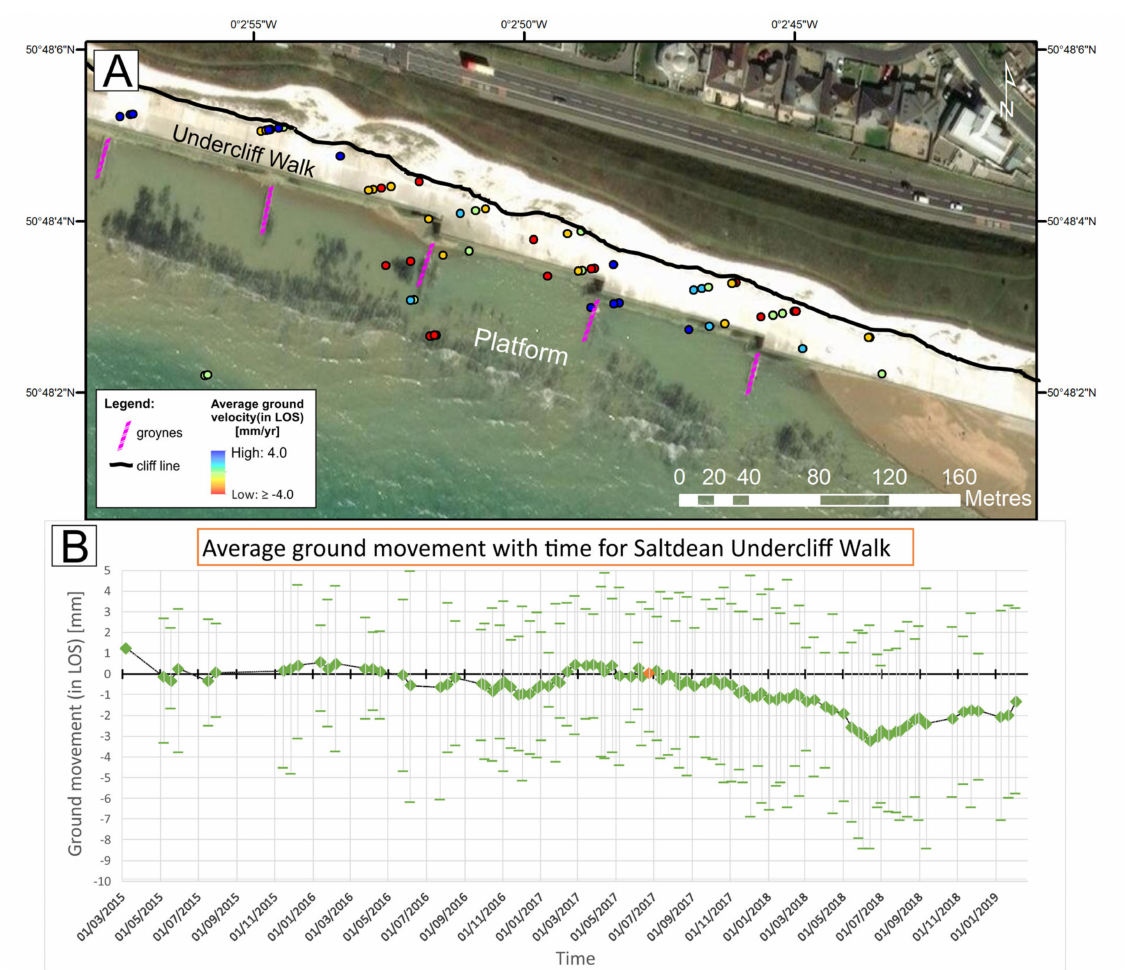
Figure11. ( A )AerialviewresultsfortheSaltdeanUndercli ff Walkresearchsite. Theplatform-engineered protection (seawall, groynes and rip-rap) and the cli ff line, presented in the top image, show an aerial view of the area of interest, with groynes as well as the cli ff line being marked. On top of the map, the average velocity of the PS points on the ground is shown in mm a − 1 , coloured adequately to the direction of the ground movement: red colours represent movement away from the satellite (downward), and blue colours mean movement towards the satellite (upwards). The bottom image ( B ) shows the average ground movement with the time for the whole area, the vertical axis displaying the ground movement in mm, and the horizontal axis showing the time frame during which the analysis was conducted (from March 2015 until January 2019). Error bars on the plot show the standard deviation calculated for the data, presented to visualise the variability. (Service Layer Credits: Esri, HERE, Garmin, © OpenStreetMap contributors and GIS user community. Source: Esri, DitalGlobe, GeoEye, Earthstar Geographics, CNES / Airbus DS, USDA, USGS, Aero GRID, IGN and GIS User